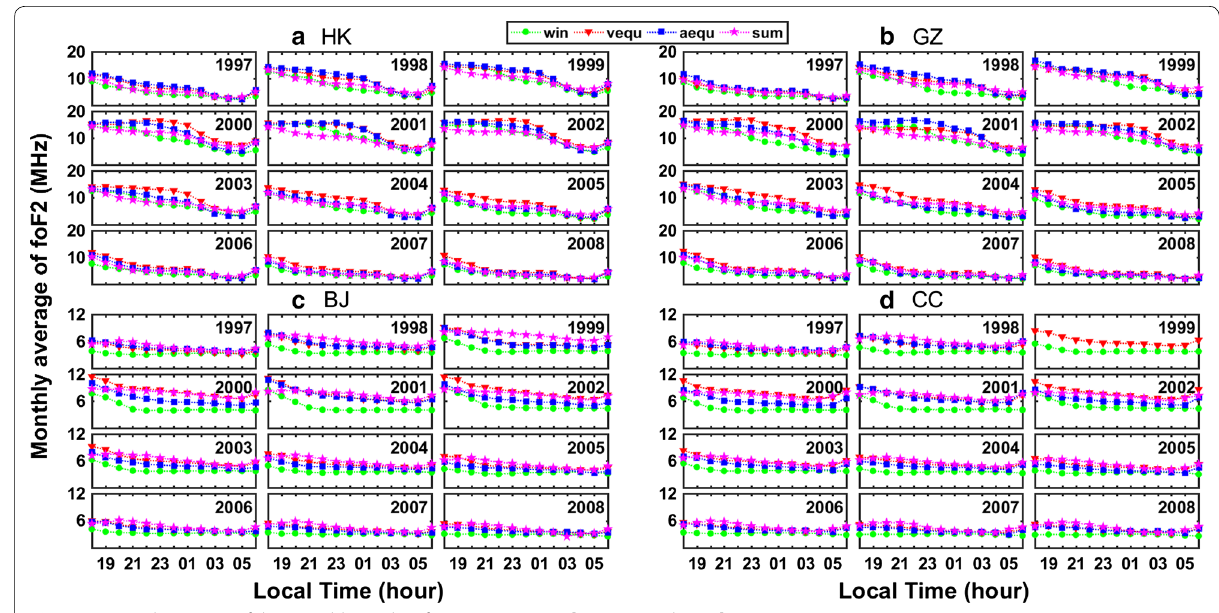
Fig. 9 Seasonal variation of the monthly median foF2 at HK ( a ), GZ ( b ), BJ ( c ), and CC ( d